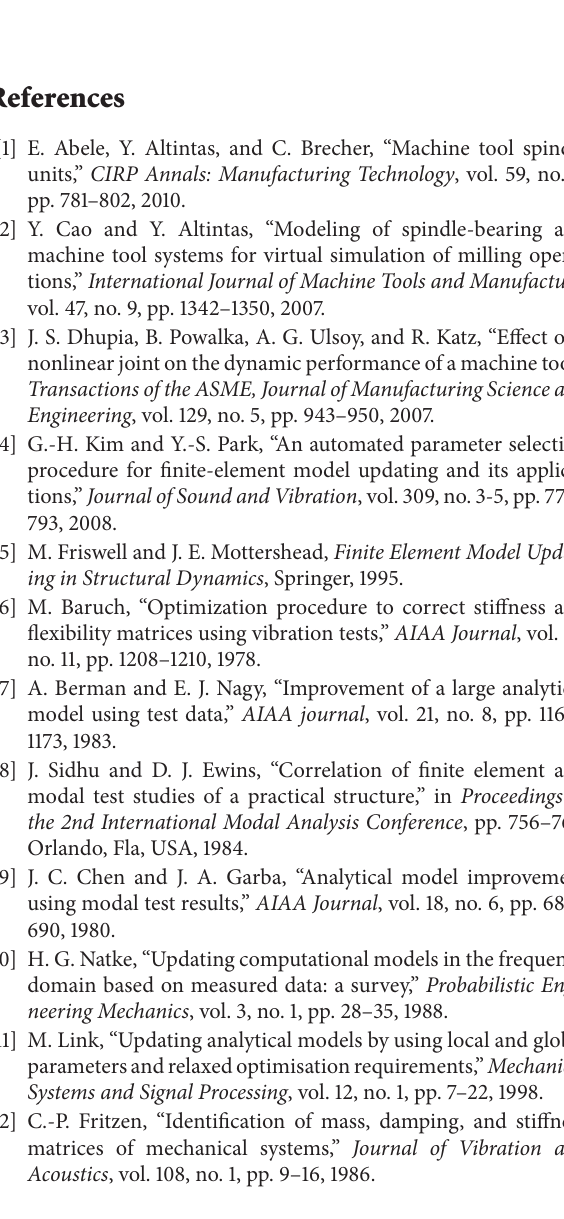
Figure 6: FRFs measurement.